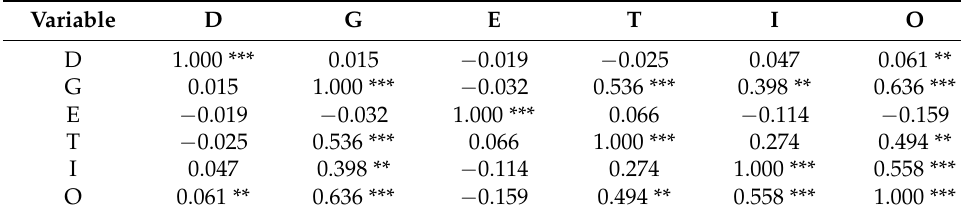
Table 6. Results of the QAP correlation analysis for each influencing factor (2020). Variable